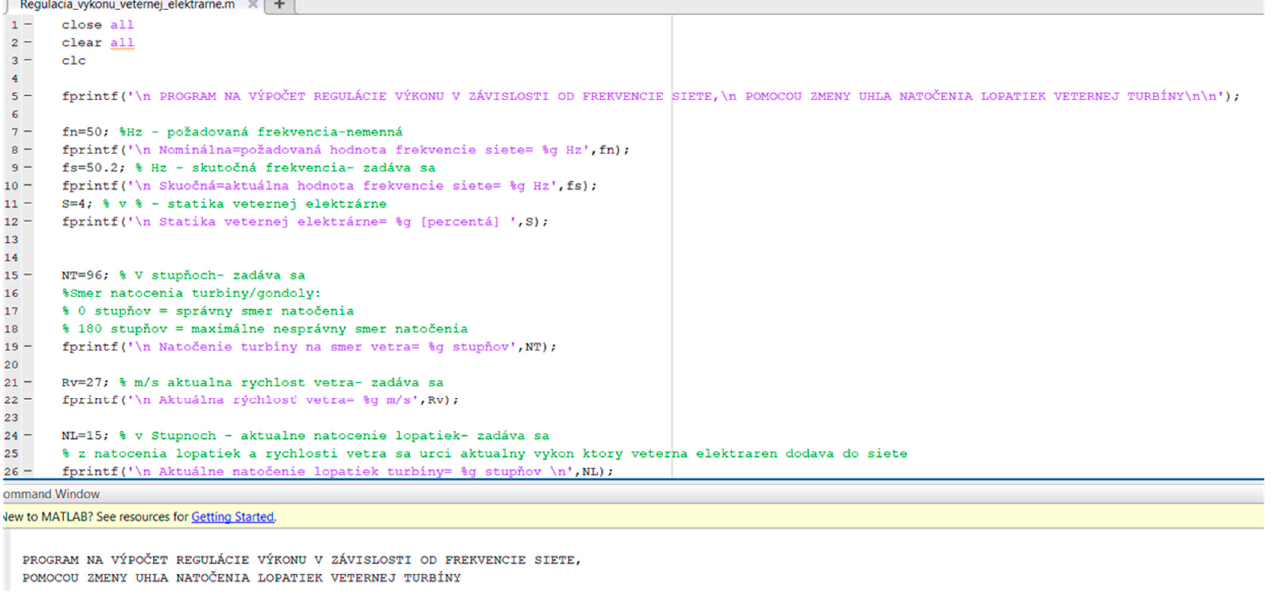
Figure 8 . MATLAB application environment-calculations [source: author’s archive] . Figure 8. MATLAB application environment-calculations [source: author’s